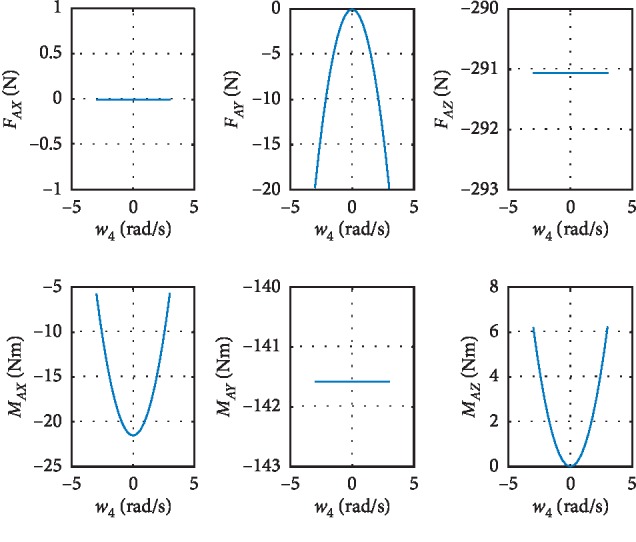
The influence of ω2 on the forces: FAx,  FAy and FAz and the moments: MAx,  MAy and MAz.